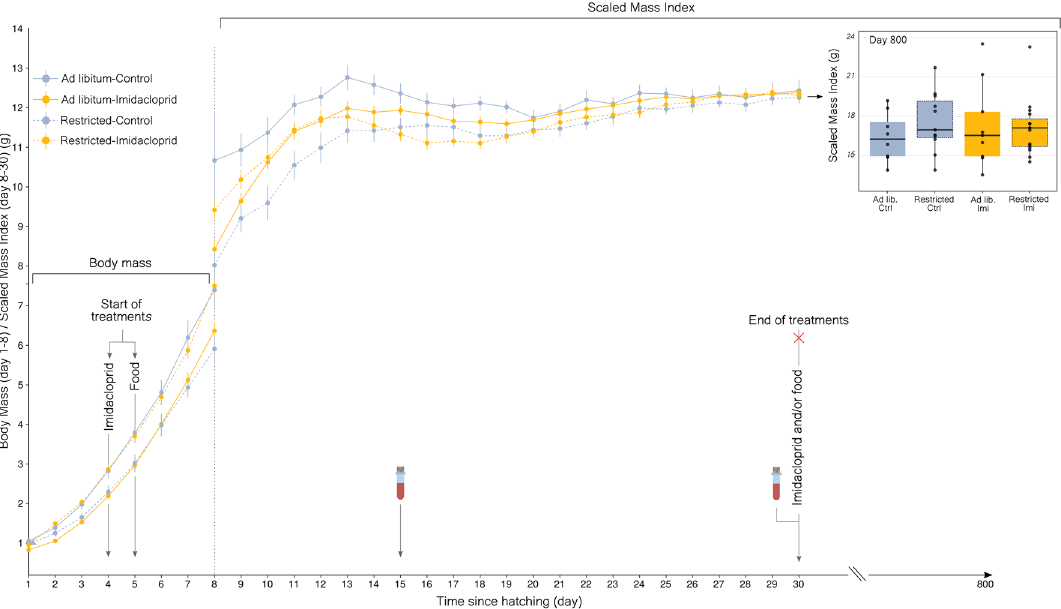
Figure 2. Mean daily body mass (s.e.m.) according to the four treatments (Day 1–30) in the second half of the 1 experiment. Daily administration of imidacloprid (0.205 mg kg body mass − mg/day) occurred from day 4 to 30 after hatching. Food treatment began on day 5. Blood samples were taken on days 15 and 30 ( Ad libitum - Control n = 18, Ad libitum -Imidacloprid n = 13, Restricted-Control n = 19, Restricted-Imidacloprid n = 10). Inserted boxplot shows body mass according to treatments on 800 day old birds. Boxes indicate interquartile range, middle lines indicate median, whiskers show the minimum and maximum values within 1.5 × the interquartile range while dots outside the whiskers represent outliers ( < 1.5 × interquartile range from